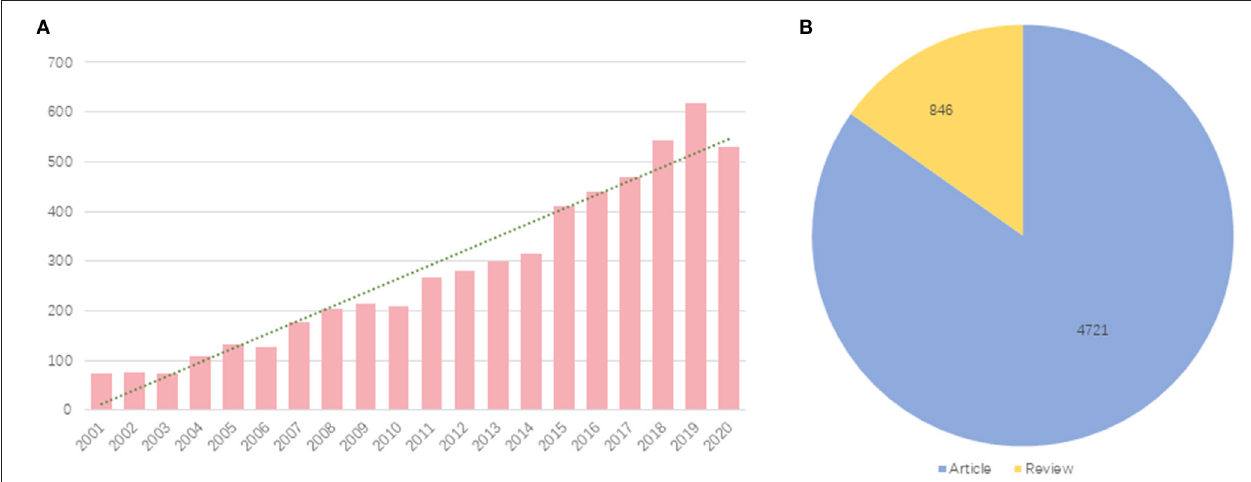
FIGURE 1 | Yearly quantity and document type of publications about cardiac rehabilitation (CR) and related research. (A) Annual quantitative distribution. (B) Document type. Blue represents articles and yellow represents